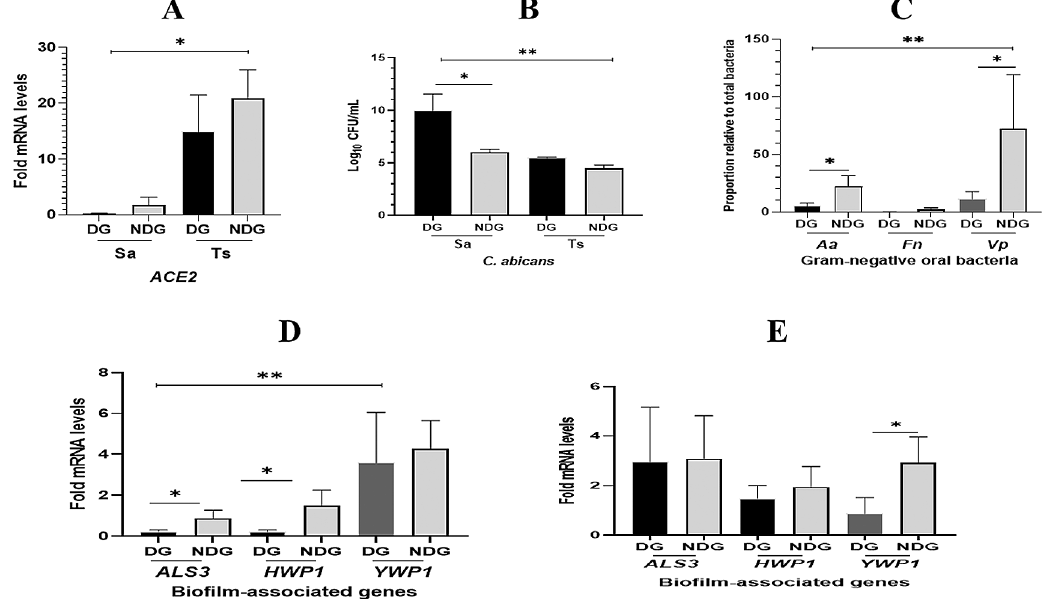
Figure 2. Evaluation of ACE2 expression, the number of C. albicans /the proportion of selected gram-negative oral bacteria [Aggregatibacter actinomycetemcomitans ( Aa ), Fusobacterium nucleatum ( Fn ), and Veillonella parvula ( Vp )], and mRNA expression of selected biofilm-associated genes ( ALS3 , HWP1 , and YWP1 ), in different patient groups (DG and NDG) of COVID-19. In general, the transcription level of ACE2 mRNA is higher in tongue surface (Ts) than those in saliva (Sa). Between groups, the different level of ACE2 expression is not significant (A). The number of C. albicans are significantly higher (p < 0.05) in saliva than in tongue surface samples, and C. albicans